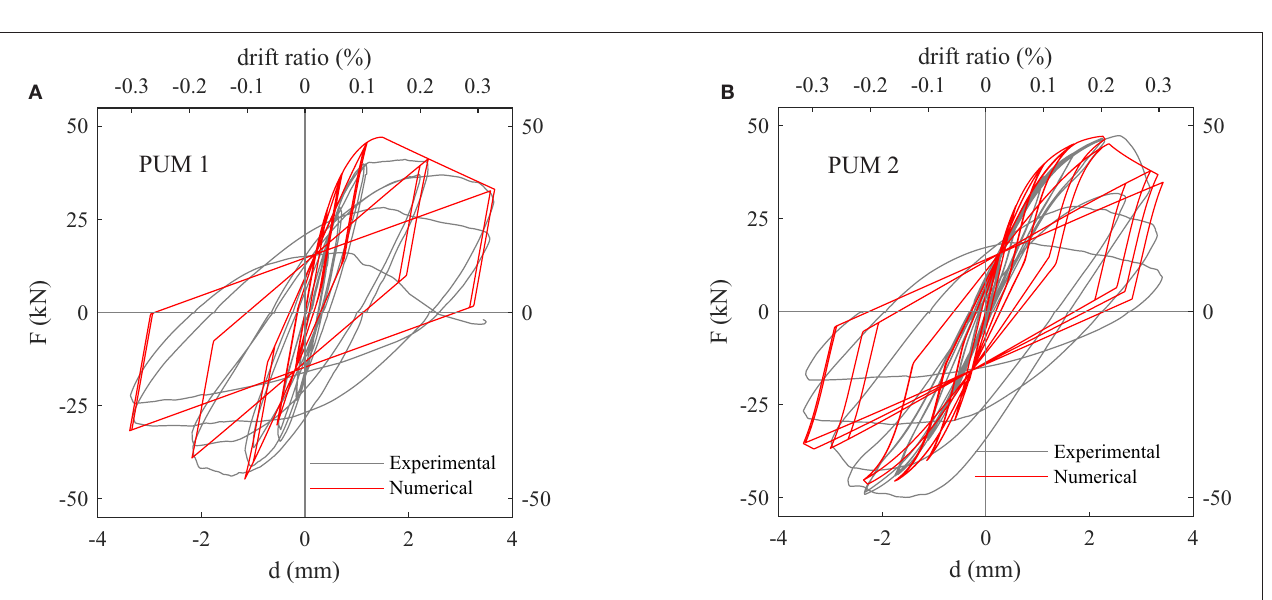
FIGURE 11 | Mixed RC/URM building: calibration of the numerical shear model based on two shear compression tests, (A) PUM1 and (B) PUM2, on scaled masonry walls, as described in Petry and Beyer